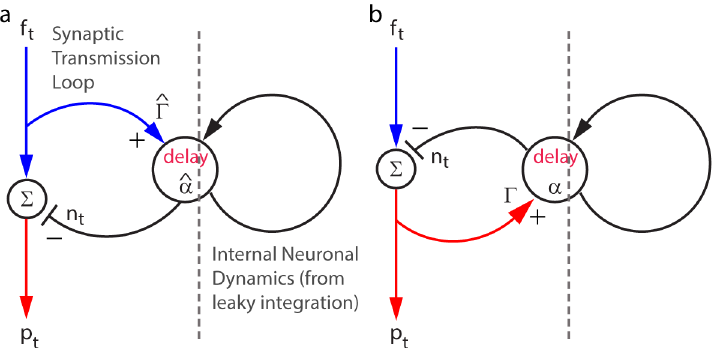
Fig 3. Schematic neural networks implementing predictive coding, through feedforward (a) or feedback (b) inhibition. Networks ’ parameters are: (a) Feedforward: a ^ , G